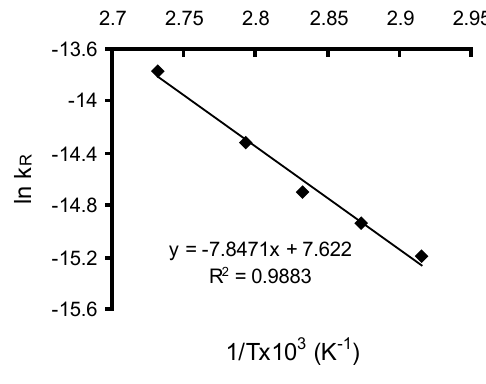
Figure 11. Arrhenius plot of lnk vs 1/T × 10 3 , K -1 . Figure 12. Concentration time profiles for reactants and products, R